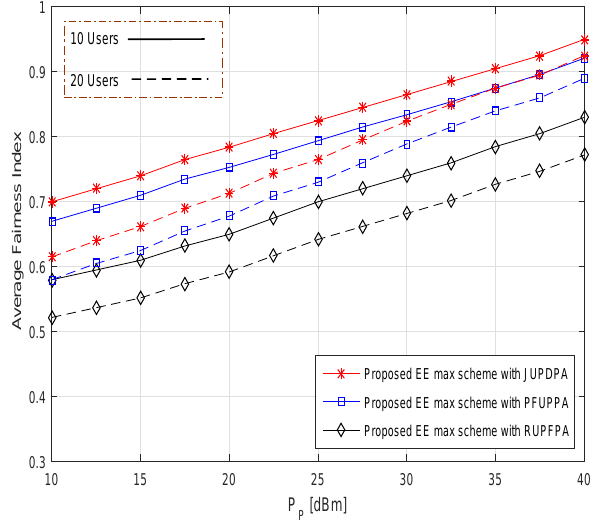
Figure 6. Average Fairness Index versus transmission power P P